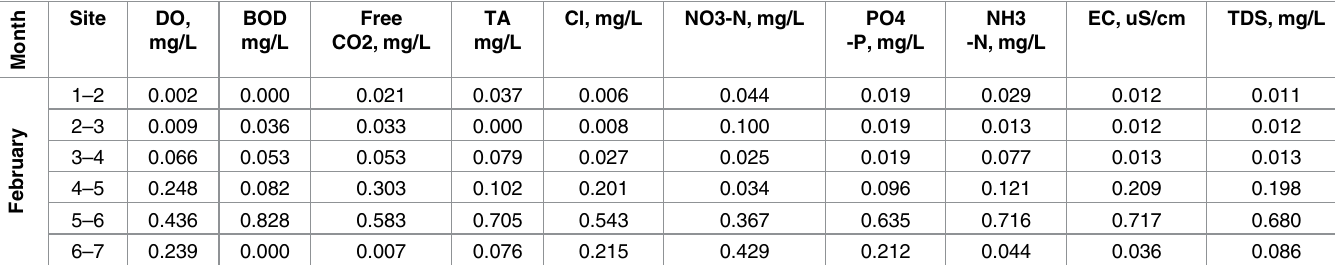
Table 6. Normalized chemical criteria in different sites of